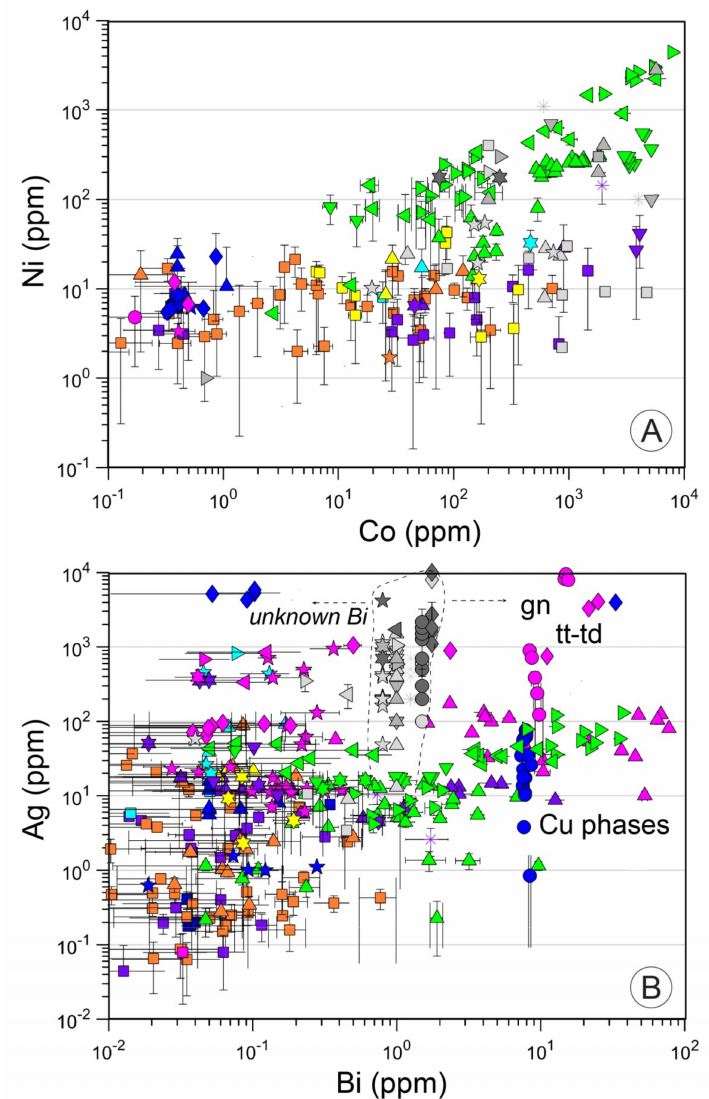
Figure 6. Logarithmic plots displaying a comparison of trace element concentrations (ppm) of ( A ) Co versus Ni ( B ) Bi versus Ag in sulfide minerals from all hydrothermal vent sites investigated during this study. Abbreviations of minerals used in this figure include tt-td ( tennantite-tetrahedrite ) and gn ( galena ). Shape denotes the type of mineral where squares: pyrite/marcasite, asterisks: pyrrhotite, triangles: Cu phases including downward-pointing triangle: isocubanite, upward-pointing triangle: chalcopyrite, right-pointing triangle: covellite/digenite/chalcocite, left-pointing triangle: bornite, diamond: tennantite-tetrahedrite, five-pointed star: Fe-poor sphalerite, six-pointed star: Fe-rich sphalerite, circles: galena. Colour dictates the tectonic setting where green: ultramafic-hosted MOR (Logatchev), orange: mature MOR (TAG), purple: high temperature MOR (Turtle Pits), cyan: immature MOR (SEPR), yellow: hot spot MOR (AS), magenta: back-arc basin (PM) and blue: volcanic arc (PVC). Shown for comparison are data from the literature in grey-scale outlined in Table S8 (light grey: MOR, middle grey: ultramafic MOR and dark grey: